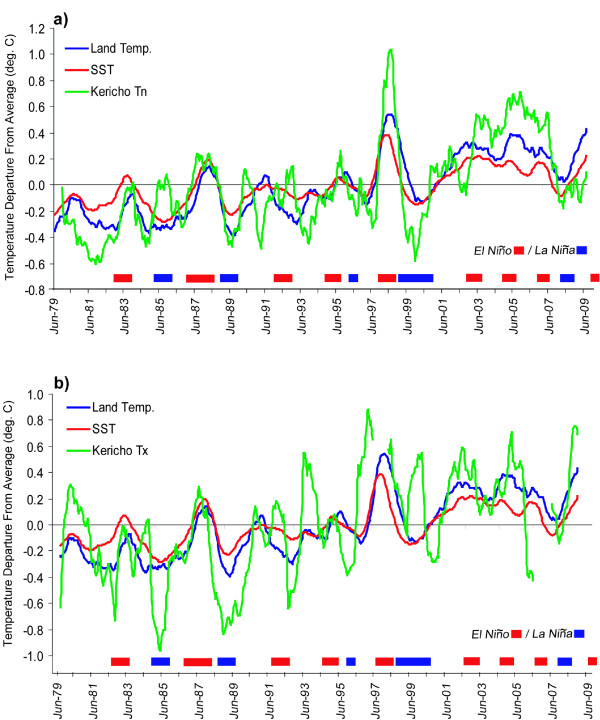
Time series of monthly departures from 1980-2009 mean values (deg. C) with an 11-month moving average applied for Kericho a) Tn and b) Tx (green line), global tropical SST (25S-25N) (red line) and tropical land area mean temperature (blue line). Color bars at the bottom of the figure show the occurrence of El Niño and La Niña events (based on the definition in use at the US Climate Prediction Center). See Table 2 for temporal correlations between these variables